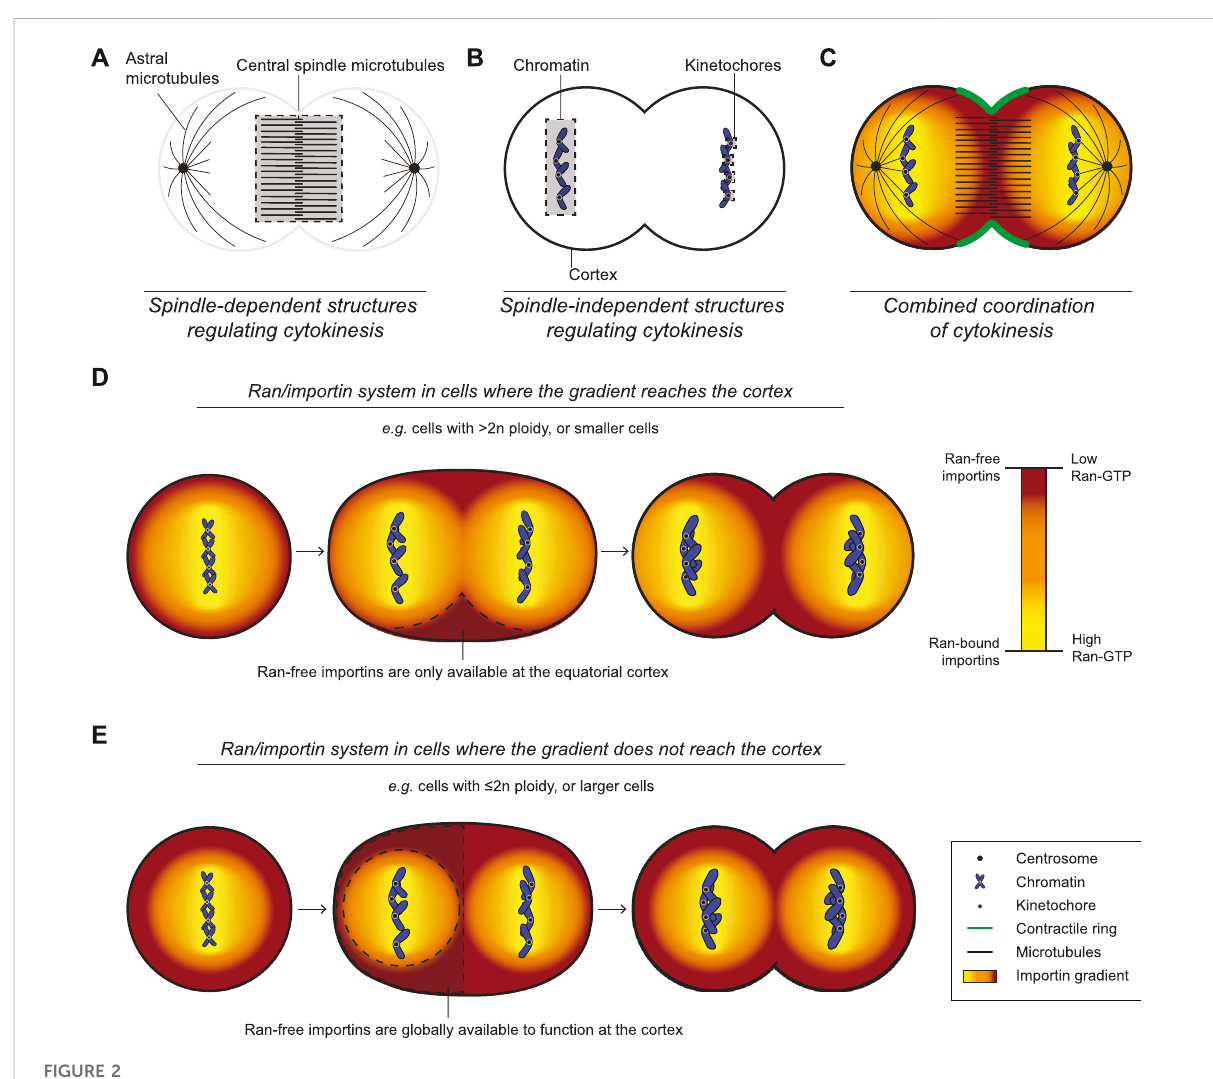
An overview of the mechanisms regulating cytokinesis. (A) A cartoon cell shows the spindle components relative to the overlying cortex in late anaphase/early telophase. (B) A similarly staged cell shows the relative locations of the chromatin, kinetochores, and cortex. (C) All of the key components from (A) and (B) are shown together in a one cell, which work together to ensure successful cytokinesis (Ran-free importins in dark orange, Ran-GTP in yellow, scale below). (D) Cartoons show how in small cells or in cells with high ploidy, Ran-GTP could restrict cortical importins, which only reach suf fi cient levels to recruit anillin to the equatorial cortex during anaphase as a dominant mechanism to control ring positioning. (E) Cartoonsshowhowinlargecellsorincellswithlowploidy,Ran-GTPmaynotreachthecortexandimportinswouldbeabletorecruit anillin uniformly to the cortex in metaphase and anaphase. These cells would require other mechanisms to control ring positioning. The legend indicates the relevant components for all cells (A – E)